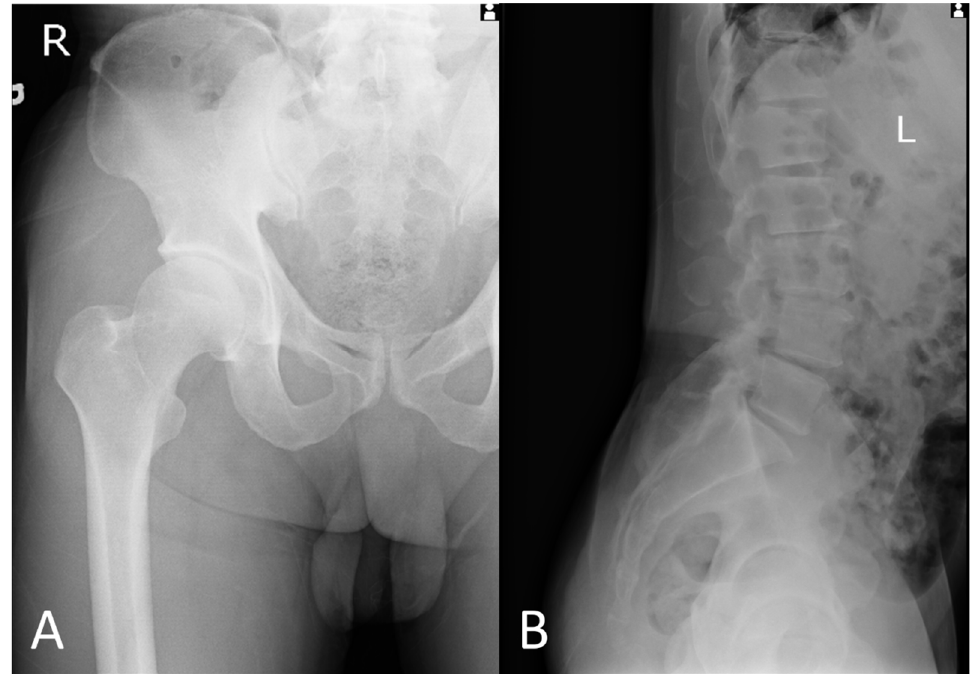
Figure 1. Plain radiographs of hip and lumbar spine. ( A ) Plain radiographs showed a hip with subtle subchondral bone sclerosis, which is compatible with early-stage OA. ( B ) Plain radiographs showed lumbar spines with spondylosis, disc space narrowing, degenerative sclerotic change at the L2/3 level, retrolisthesis at the L2/3, L3/4 level, and grade I spondylolisthesis at the L4/5 level, however not related to this acute pain.